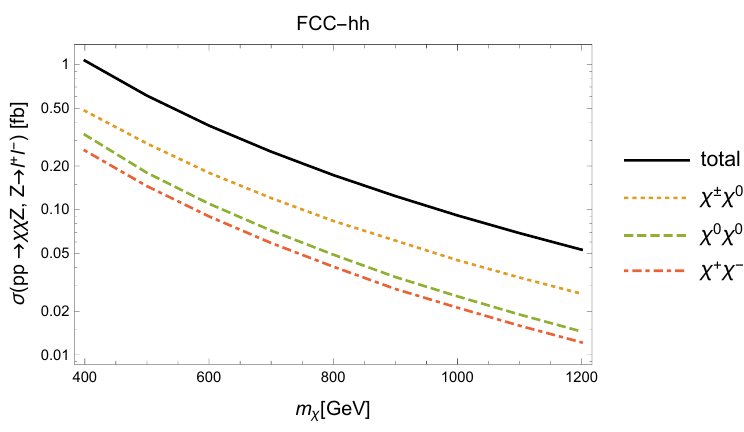
Figure 2 . Inclusive production cross sections for pp ! (cid:31)(cid:31)Z ; ( Z ! ‘ + ‘ (cid:0) ), for weak-doublet Dirac fermion (cid:31) with hypercharge -1 = 2 at a future hadron-hadron collider with 100 TeV centre-of-mass energy. We assume that inter-state splittings are small enough to have a negligible